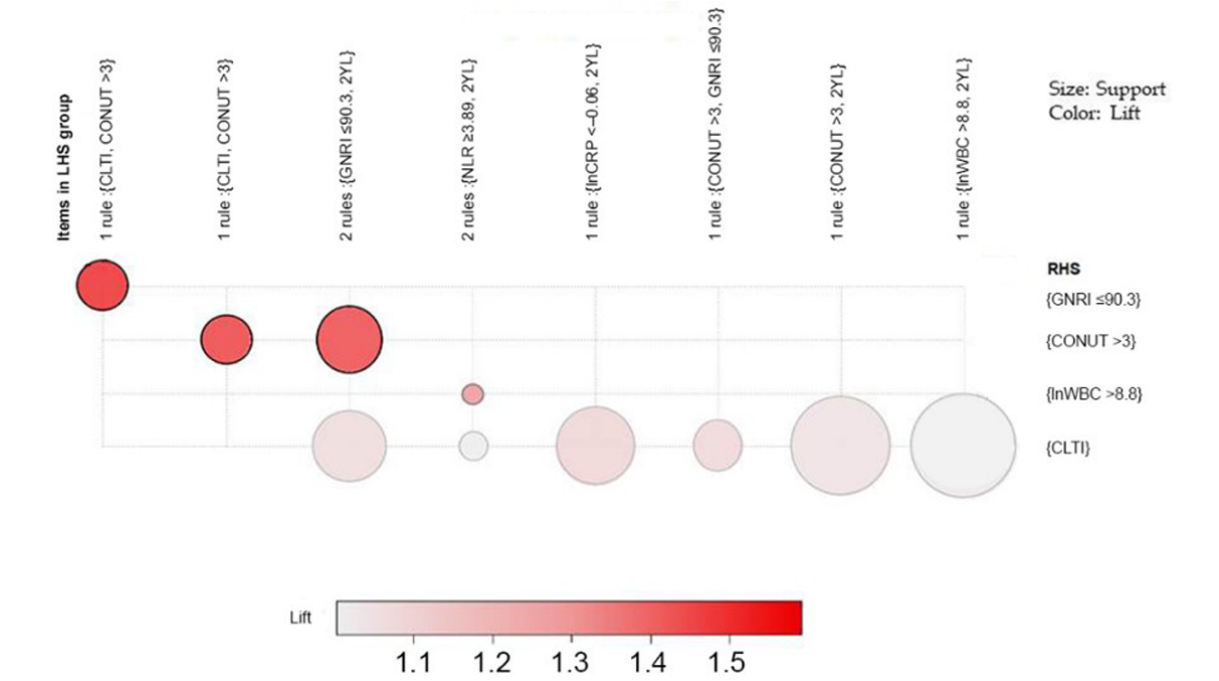
Figure 4. Grouped matrix for 10 rules. The graph-based visualization uses color or size to represent the set of items and rules. This graph offers a representation of rules and enables a small set of rules to avoid a cluttered presentation. The left-hand side shows the antecedents and the right-hand side shows the consequents. 2YL: 2-year longevity; CLTI: chronic limb-threatening ischemia; CONUT: Controlling Nutritional Status; CRP: C-reactive protein; GNRI: Geriatric Nutritional Risk Index; LHS: left-hand side; NLR: neutrophil-lymphocyte ratio; RHS: right-hand side; WBC: white blood